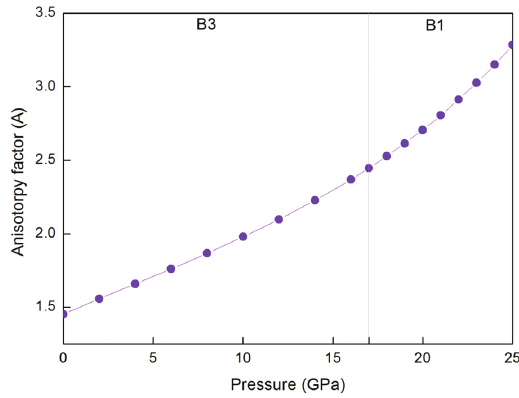
Figure 9. Anisotropy factor of GaAs versus pressure.